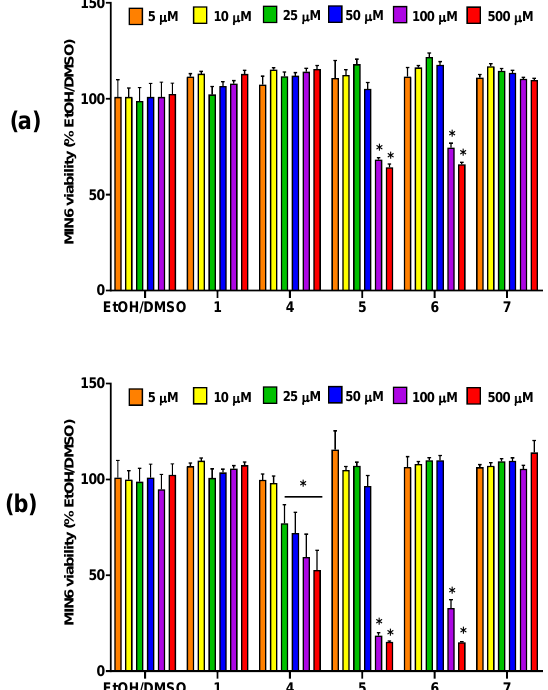
Figure 2. MIN6 cells viability after 24-h ( a ) and 48-h ( b ) treatment in fasting conditions with p -anisic acid (1), phosphatidylcholines substituted with at anisic and/or palmitoyl acyl residues in different configurations (4–6), and 1-anisoyl-lysophosphatidylcholine (LPC) (7) in the range of 5–500 μM concentrations. The viability is expressed as % of viable cells after treatment with respective quantities of the compound solvent (EtOH/DMSO). * p < 0.05 is regarded as significantly different from EtOH/DMSO.